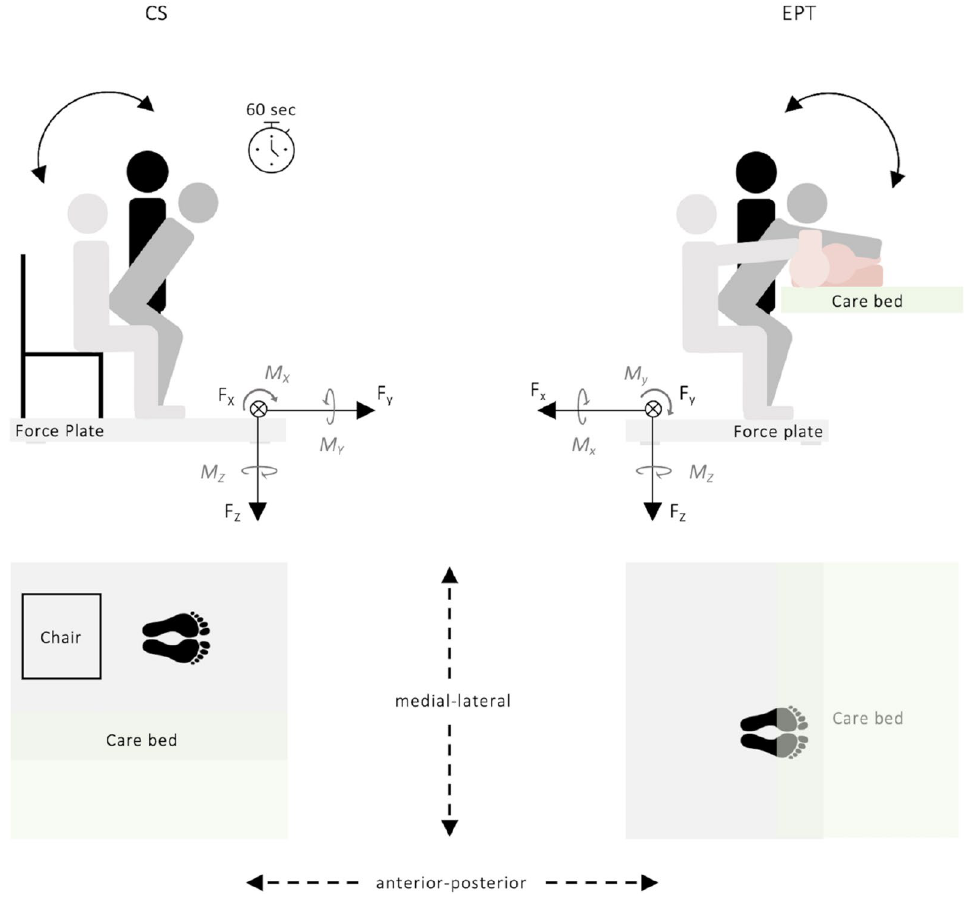
Figure 1. Schematic representation of the study configuration of the chair squat (CS) and the ergonomic patient transfer (EPT) task. F X , F Y , F Z indicate ground reaction forces and their direction; M X , M Y , M Z indicate moments and their